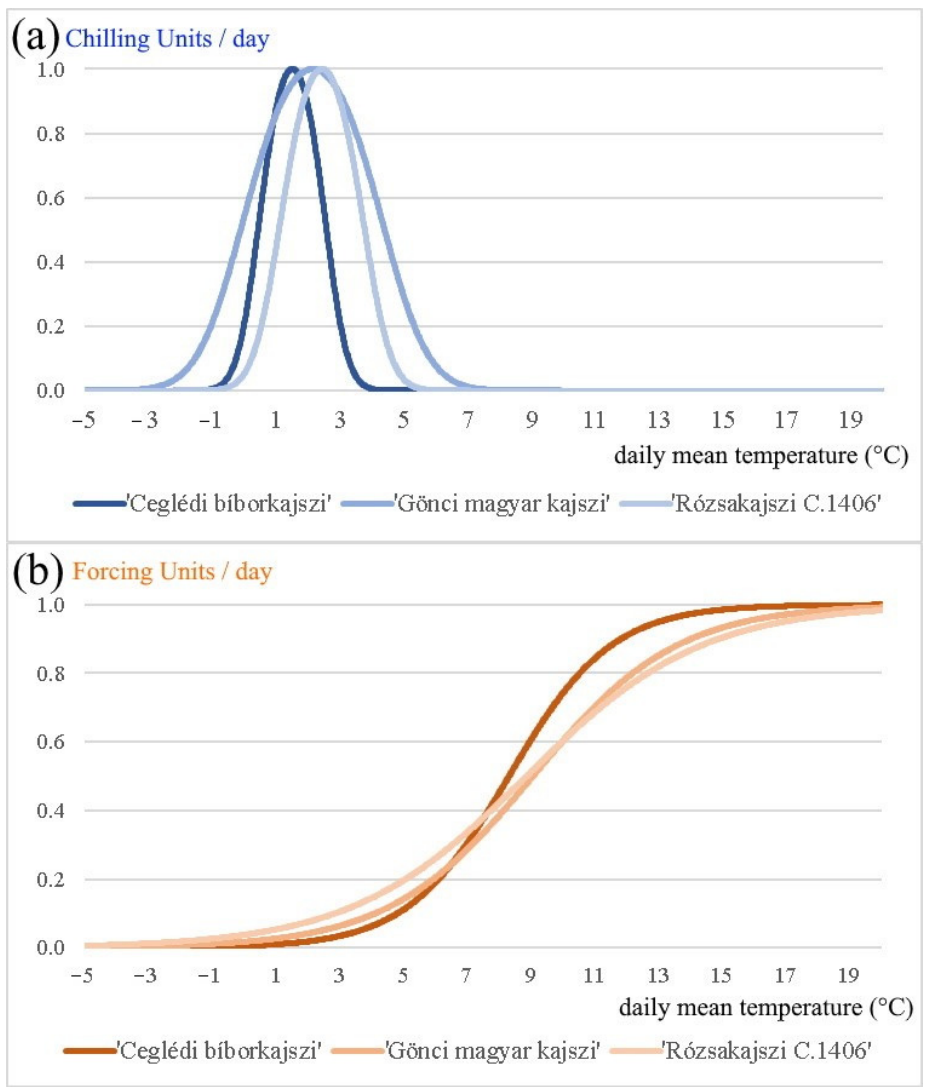
Figure 1. The schematic diagram of the chilling (upper panel: ( a )) and forcing (lower panel: ( b )) unit accumulation depending on the daily mean temperature for ’Ceglédi bíborkajszi’, ’Gönci magyar kajszi’, and ’Rózsakajszi C.1406 ′ .